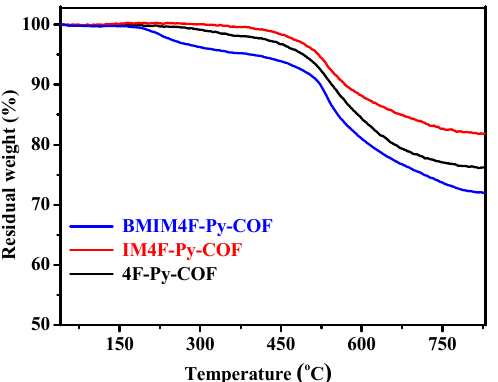
Figure 5. TGA curves of IM4F-Py-COF, BMIM4F-Py-COF, and 4F-Py-COF. 2.2. Catalytic Performance of